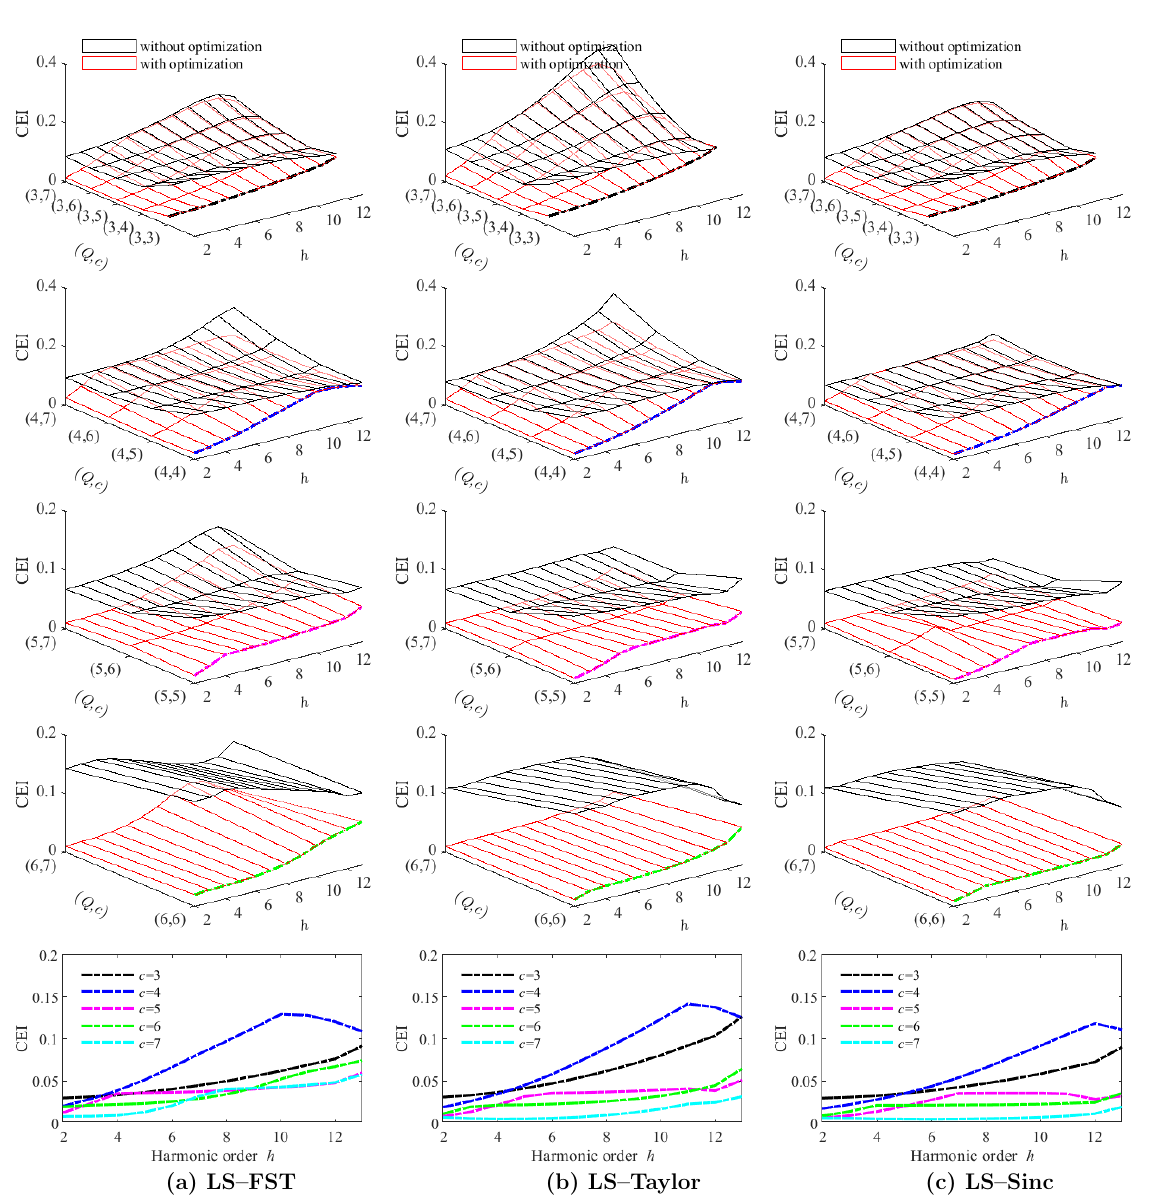
Figure 4. The subplots in the first four rows show the variation of the CEI for each harmonic with the window length c when keeping the signal model order Q constant for the three least-square algorithms with and without the proposed optimization. The last row of subplots summarizes the CEI as c = Q